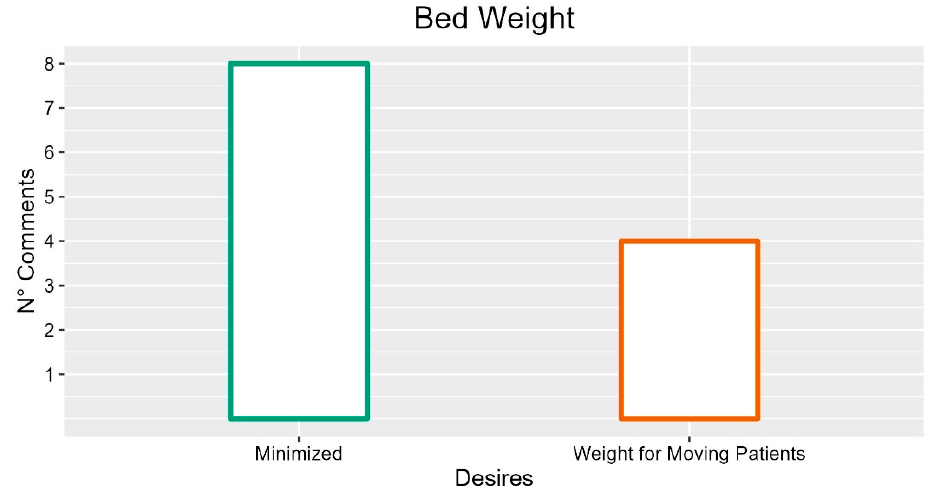
Figure 12. Graphical representation of desires with more occurrences for the Bed Weight theme.